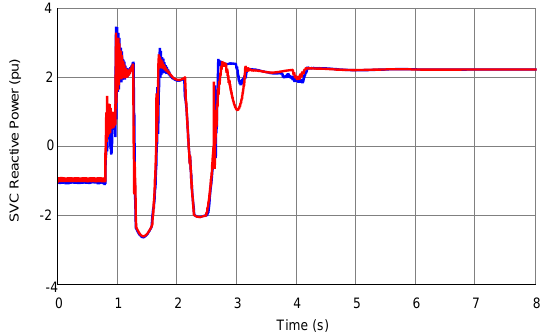
Figure 13. Transient reactive power injected by the SVC due to a 10-cycle fault: RTDS-based WAC-SVC (red), and delay-compensated HIL-based WAC-SVC